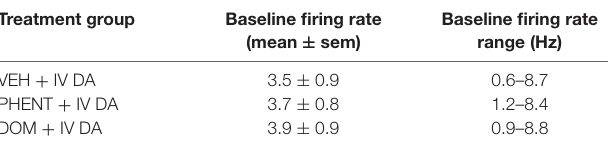
TABLE 2 | This table contains information about the firing rate of recorded neurons. Treatment